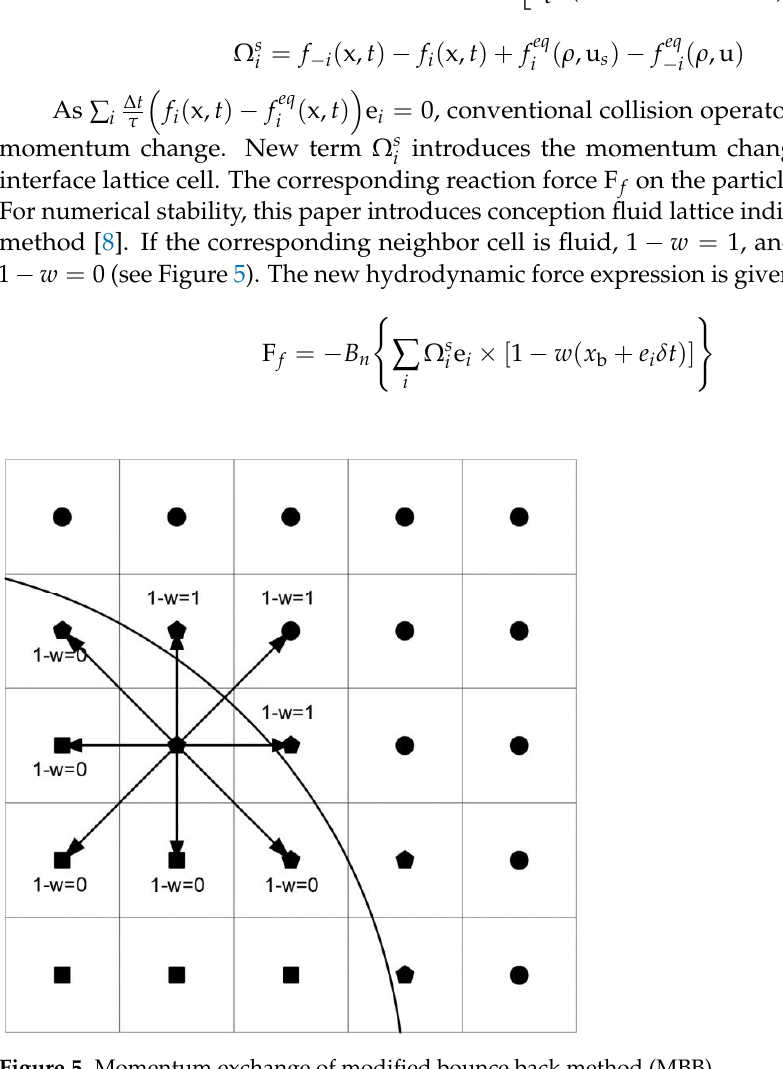
Figure 5. Momentum exchange of modified bounce back method